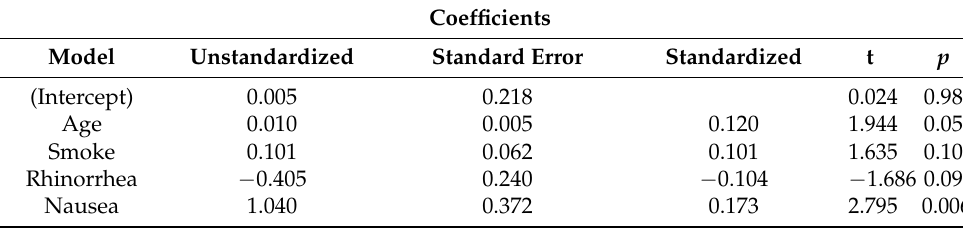
Table 4. Linear regression coefficients of predictors of total LUS in COVID-19 negative subjects.